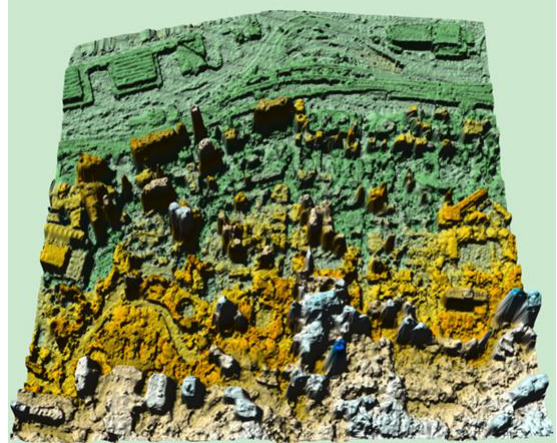
Fig.11 The DSM from the SGM in Hong Kong